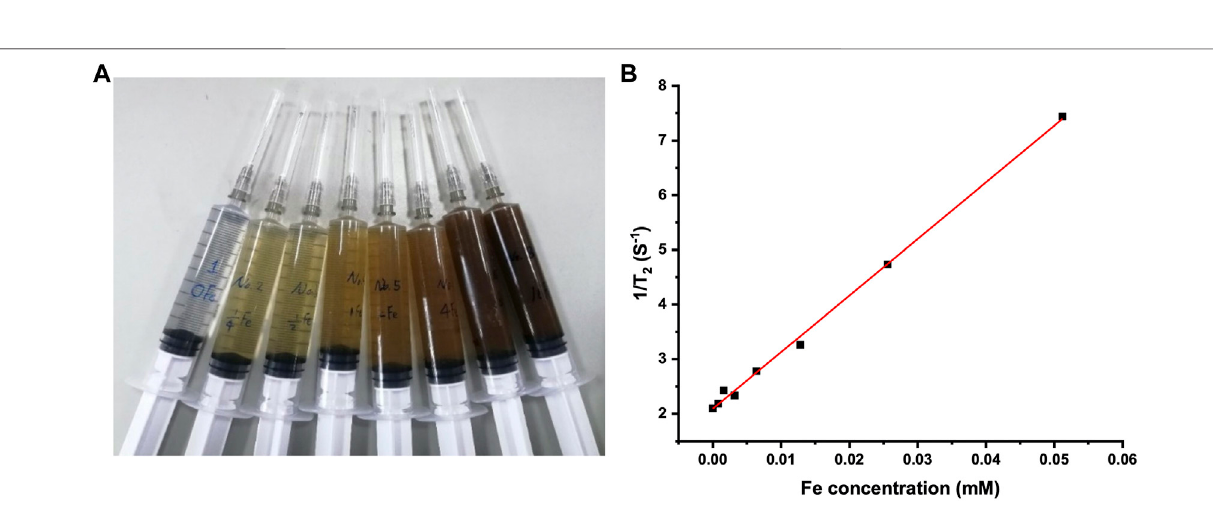
FIGURE 1 | Transmission electron microscopy image of the Fe 3 O 4 nanoparticles and optical microscopy images of the Fe 3 O 4 @Agar microspheres.